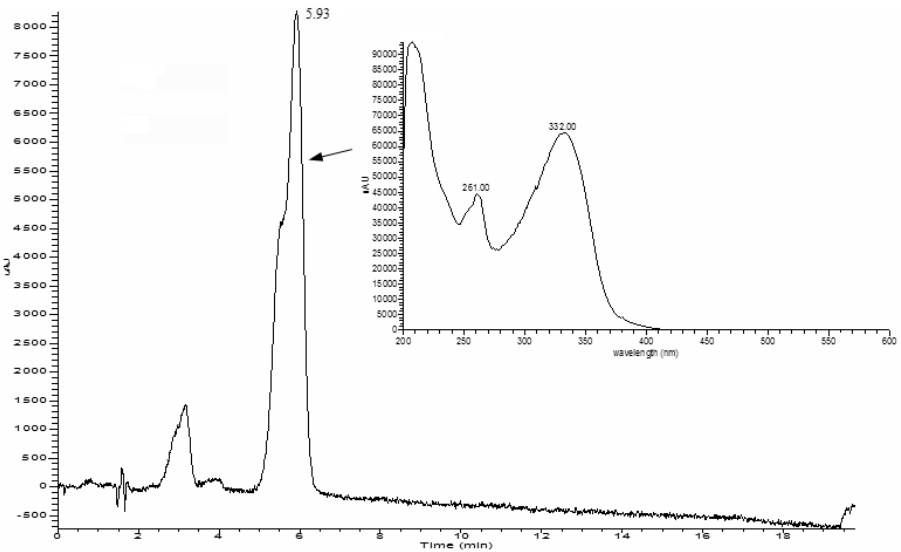
Figure 2. HPLC-PDA profile of camellianin A.